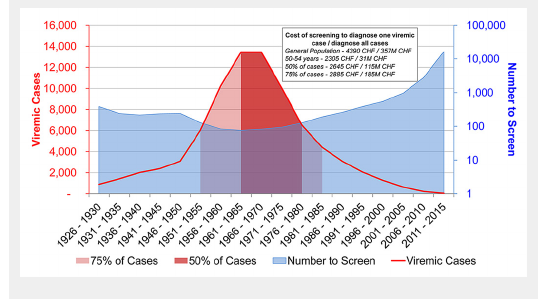
Percent of cases by 5-year birth cohort, the number of individuals needed to test in order to diagnose one viraemic case, and the associated cost to diagnose one viraemic case by birth cohort of